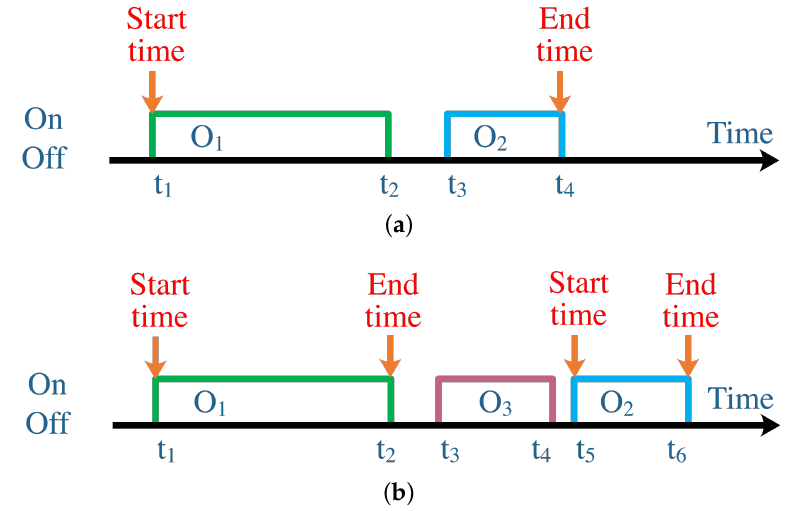
Figure 5. We propose two strategies to determine the start time and end time. O 1 and O 2 are objects that belong to one activity, and O 3 belongs to some other activity. ( a ) No interruption between two objects; ( b ) Interruption between two